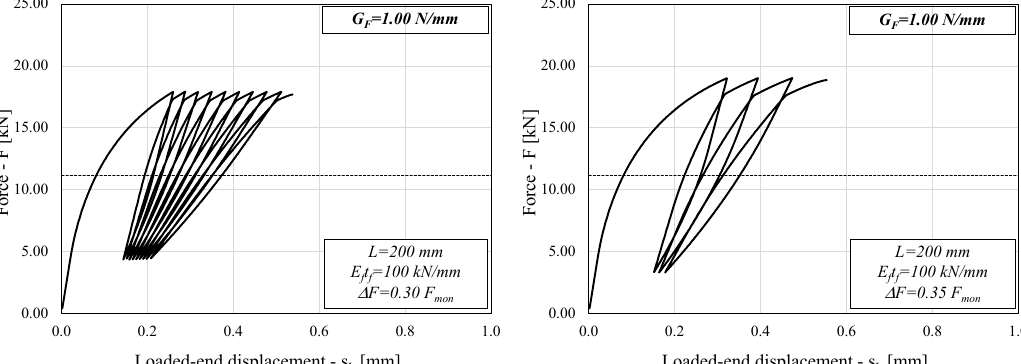
F = 0.60 N/mm). Figure 3. Load–slip curve (L = 200 mm, G